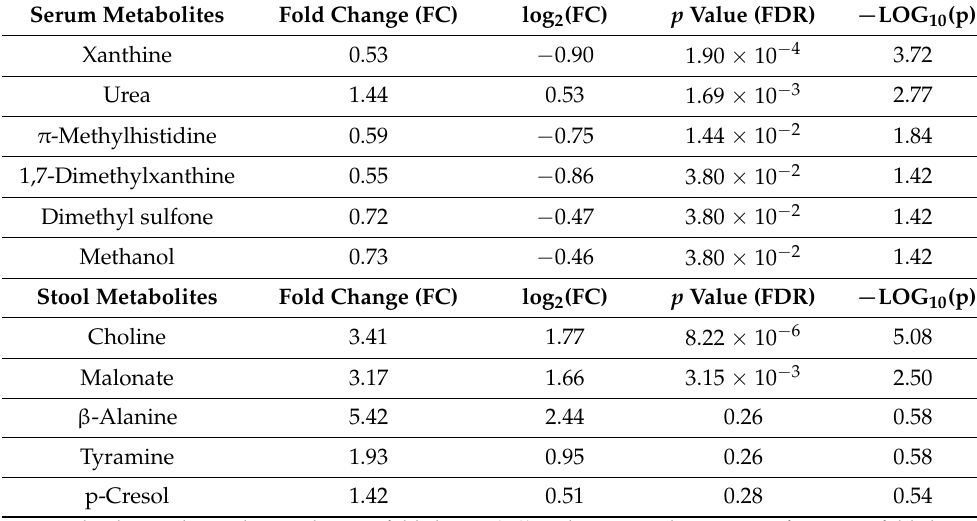
Table 1. Unpaired volcano plot analysis of serum and stool metabolite concentrations between the FD patient and control relative sample